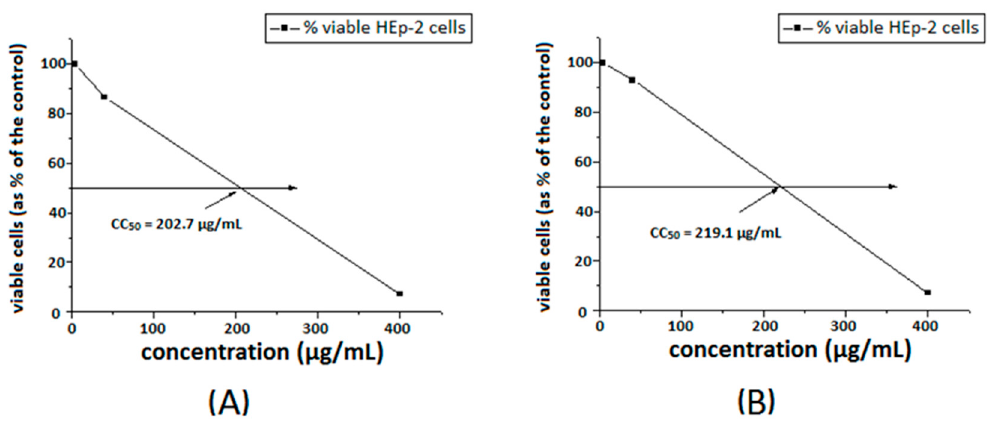
Figure 7. Cytotoxic concentration 50% of ligand S1 ( A ) and [Cu 3 (S1)] ( B ), in HEp-2 cell culture.